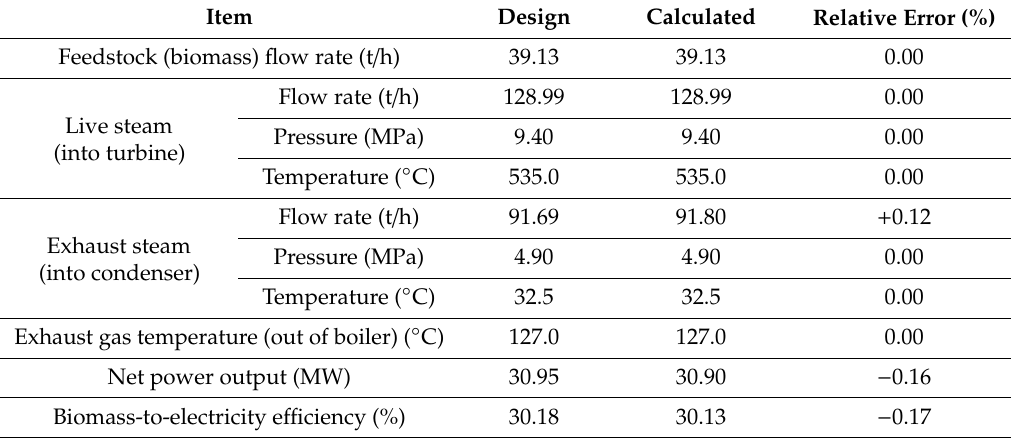
Table7. Comparisonofthesimulationresultsanddesigndataofthereferencebiomass-firedpowerplant. Item